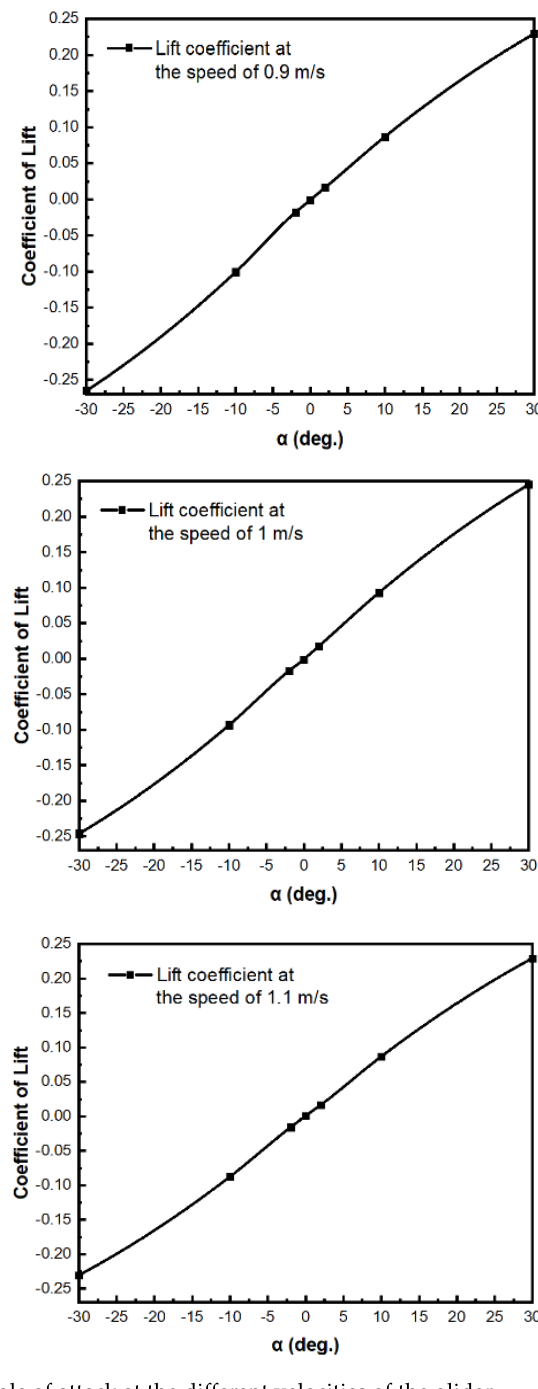
Figure 11. The lift and drag coefficients versus the angle of attack at the different velocities of the glider.